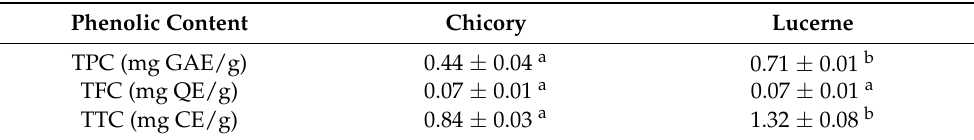
Table 1. Total phenolics content (TPC), total flavonoids content (TFC) and total tannins content (TTC) of chicory and lucerne.